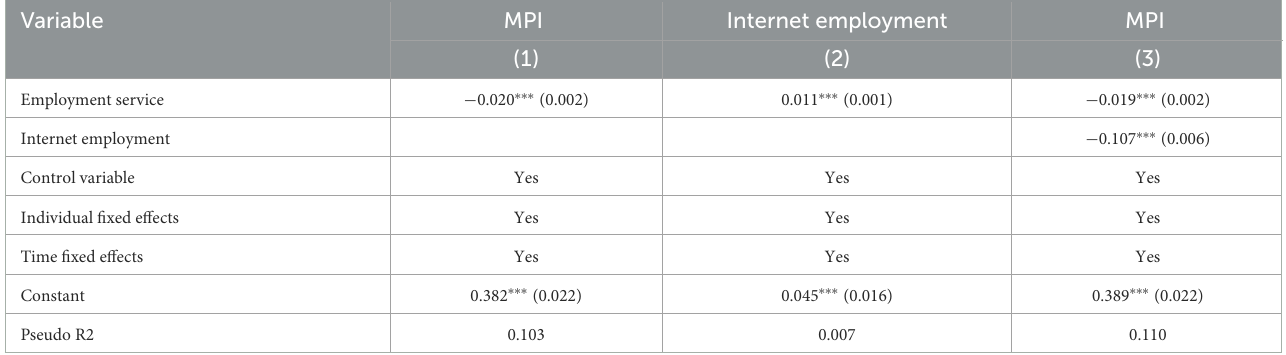
TABLE 12 Results of the mediation effect test of Internet employment. Variable